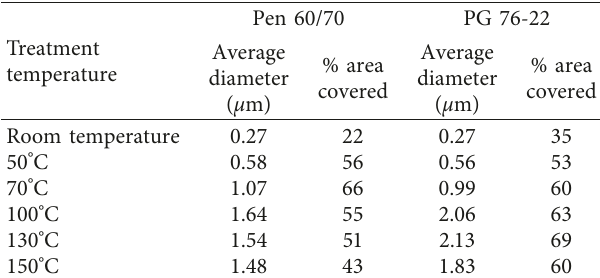
Figure 7: A detail view of all morphological phases in asphalt. Table 3: Effect of temperature on diameter and area coverage of bee structure in asphalt. The table is reproduced from Menapace [27] (under the creative commons attribution license/public